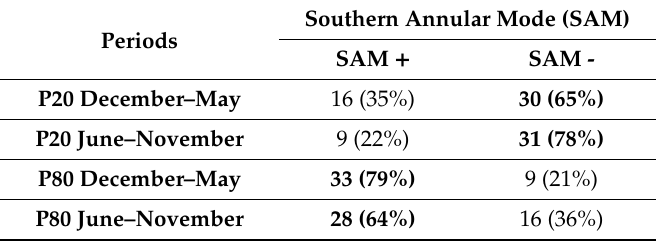
Table 3. Total and relative frequencies (values in parenthesis) of the number of months with P20 and P80 moisture sink events occurring in each phase of the SAM. The highest values are highlighted in bold.